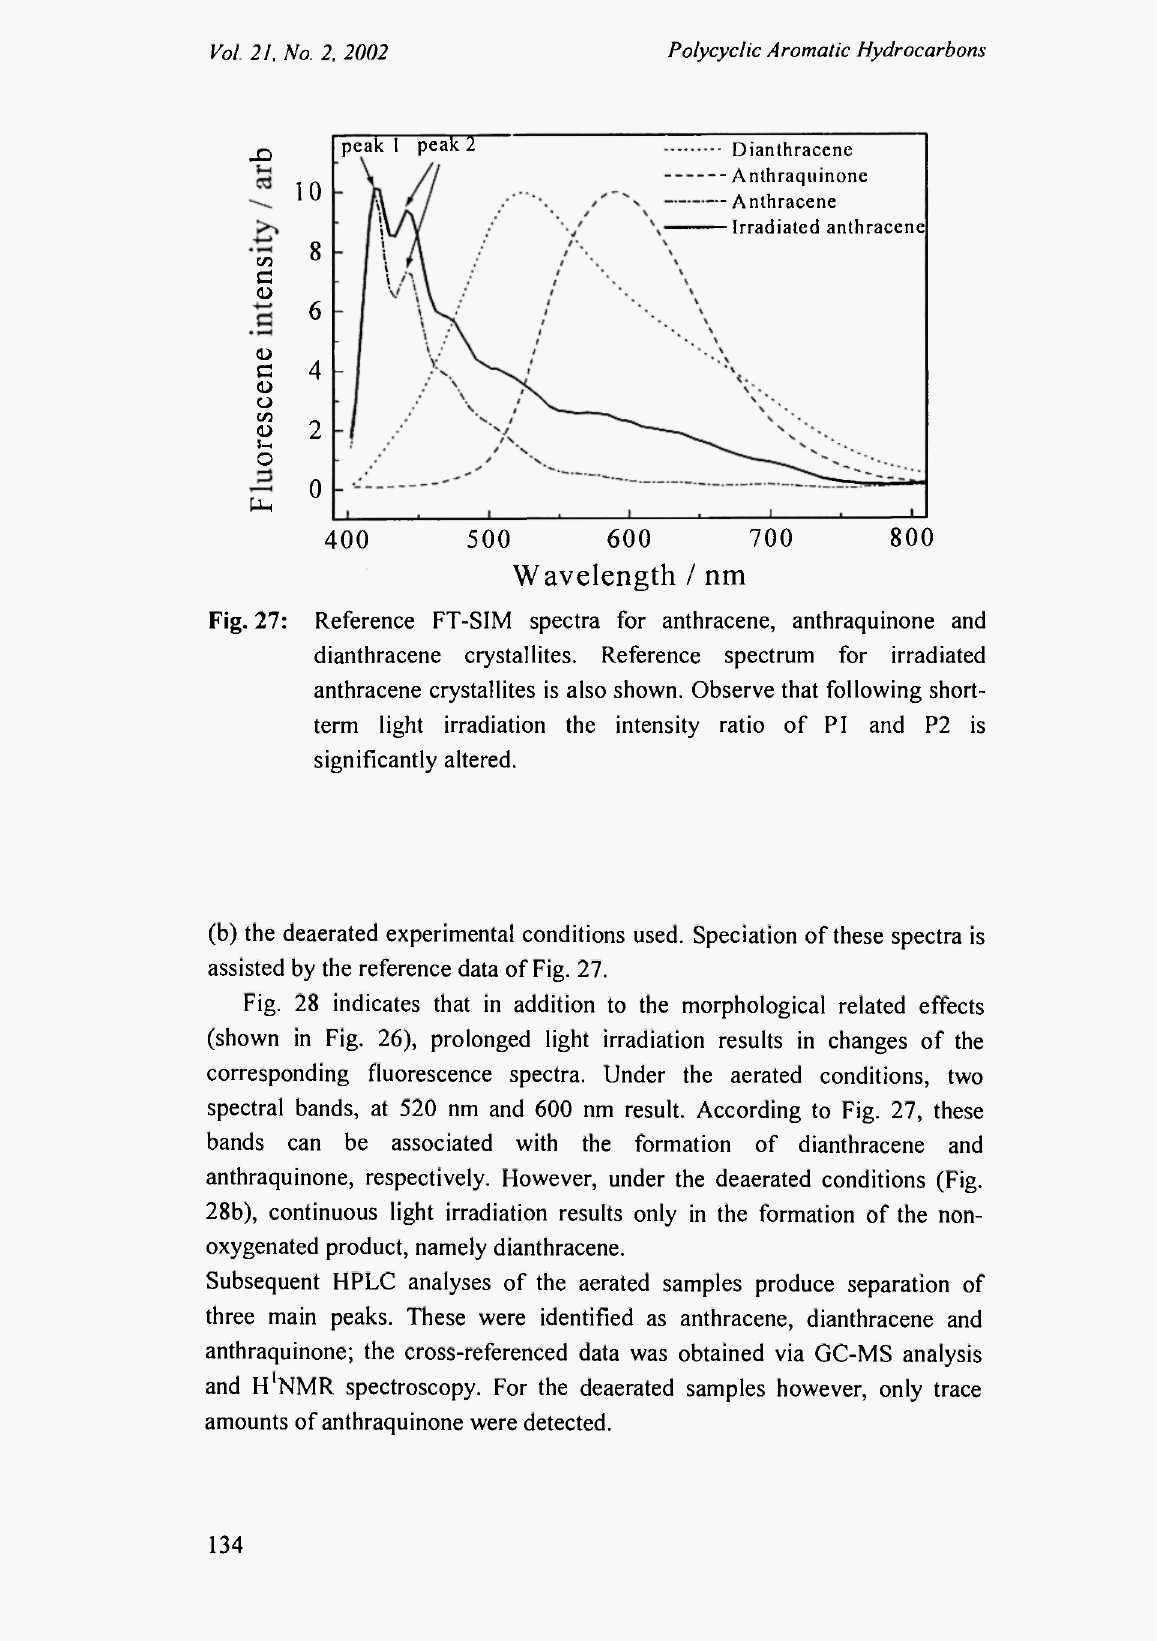
4 00 800 500 600 700 Wavelength / nm Fig. 27: Reference FT-SIM spectra for anthracene, anthraquinone and dianthracene crystallites. Reference spectrum for irradiated anthracene crystallites is also shown. Observe that following short- term light irradiation the intensity ratio of PI and P2 is significantly